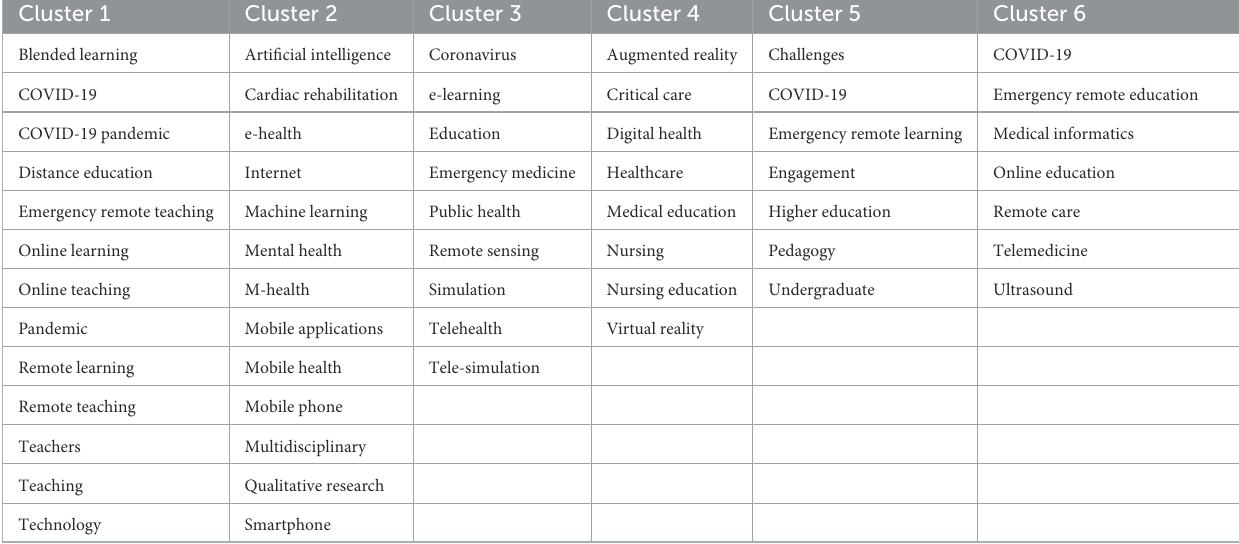
TABLE 1 Keywords classified as six clusters by